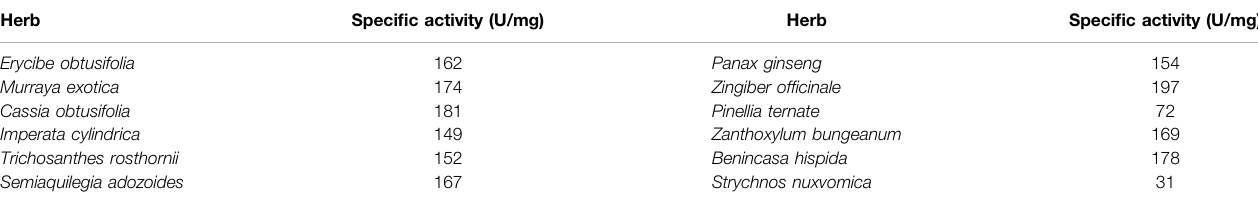
TABLE 1 | Enzyme activity measurement of Erycibe obtusifolia , Panax ginseng , Murraya exotica , Zingiber of fi cinale , Cassia obtusifolia , Pinellia ternate , Imperata cylindrica , Zanthoxylum bungeanum , Trichosanthes rosthornii , Benincasa hispida , Semiaquilegia adozoides and Strychnos nuxvomica based on colorimetric assay.